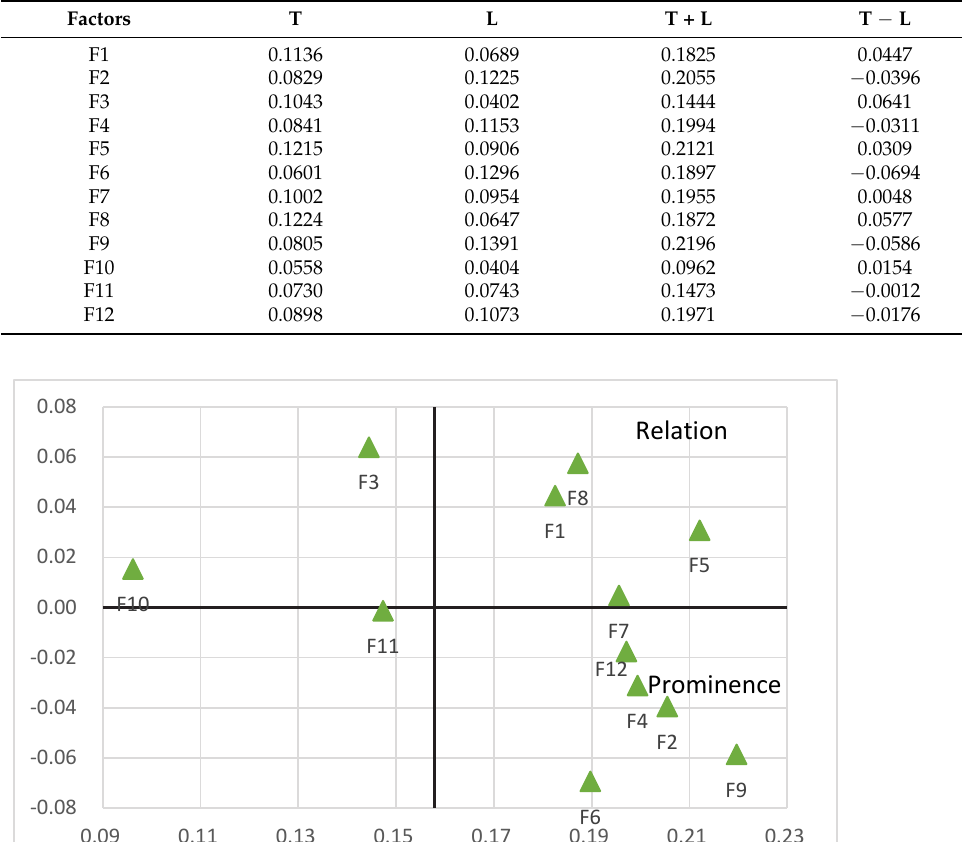
Table 12. Prominence and relation of value elements.